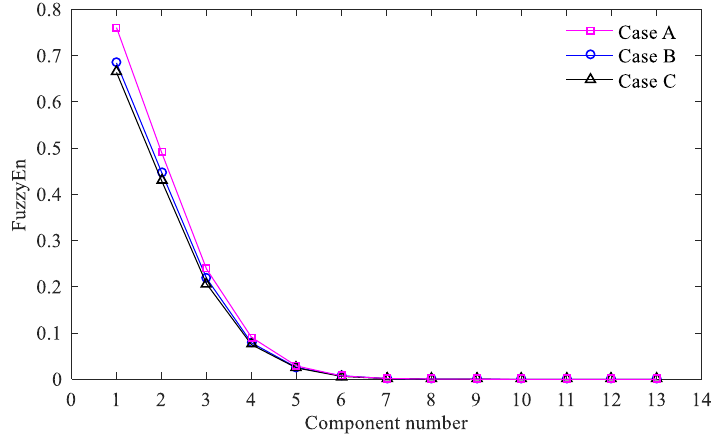
Figure 7. The FuzzyEn of each component obtained by EEMD.